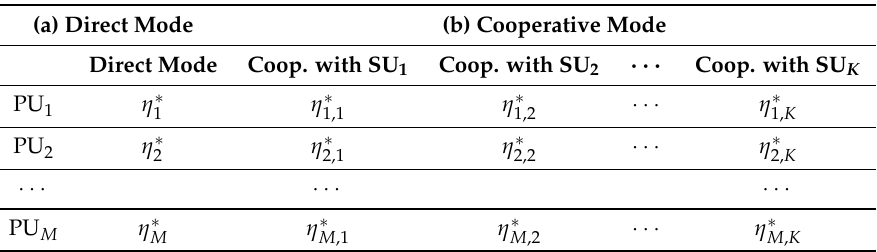
Table 1. Tables of direct mode and cooperative